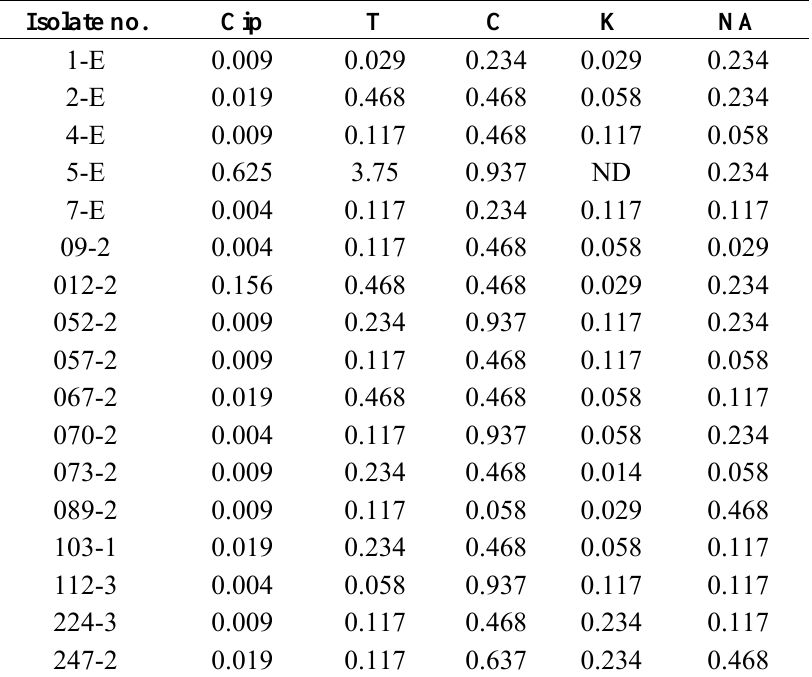
Table 3. Minimum inhibitory concentration (MIC E. cloacae